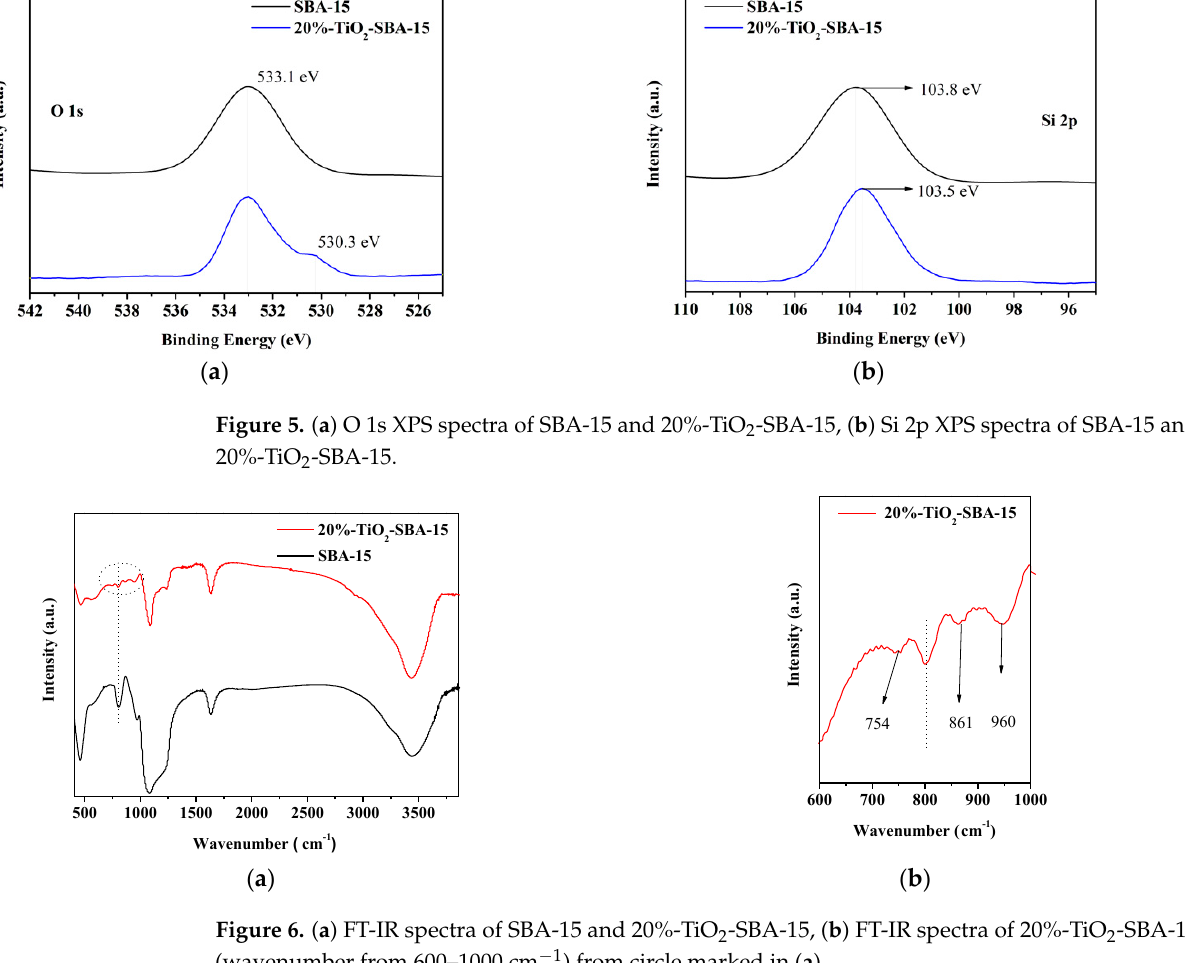
Figure 6. ( a ) FT-IR spectra of SBA-15 and 20%-TiO 2 -SBA-15, ( b ) FT-IR spectra of 20%-TiO 2 -SBA-15 (wavenumber from 600–1000 cm − 1 ) from circle marked in ( a ).